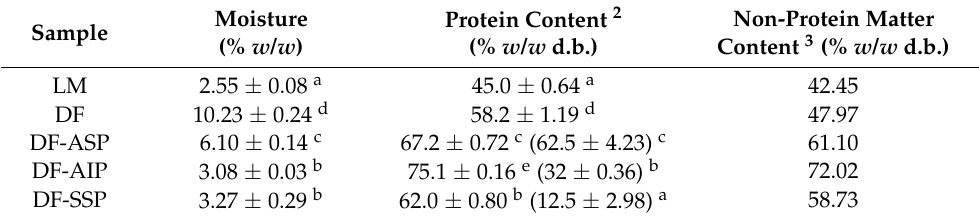
Table 1. Proximate chemical composition 1 of LM, DF, and protein preparations.